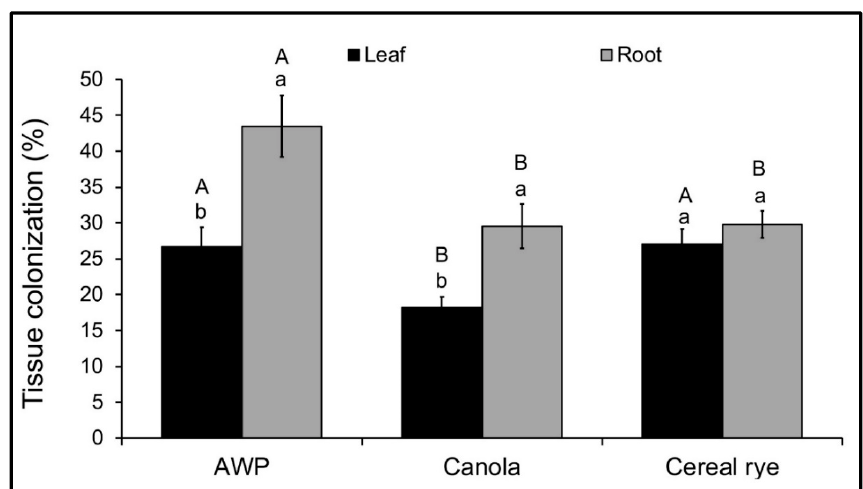
Figure 2. Percentage of root or leaf endophytically colonized in cover crops grown from M. robertsii - inoculated seeds of AWP (leaf n = 312, root n = 312), cereal rye (leaf n = 408, root n = 408) and canola (leaf n = 306, root n = 306). Error bars represent ± standard error of the mean. The lowercase letters show the difference between root and leaf colonization within a cover crop species. The uppercase letters show the differences among cover crop species where leaf or root tissues were analyzed separately. The bars sharing common letters are not significantly different at p = 0.05.